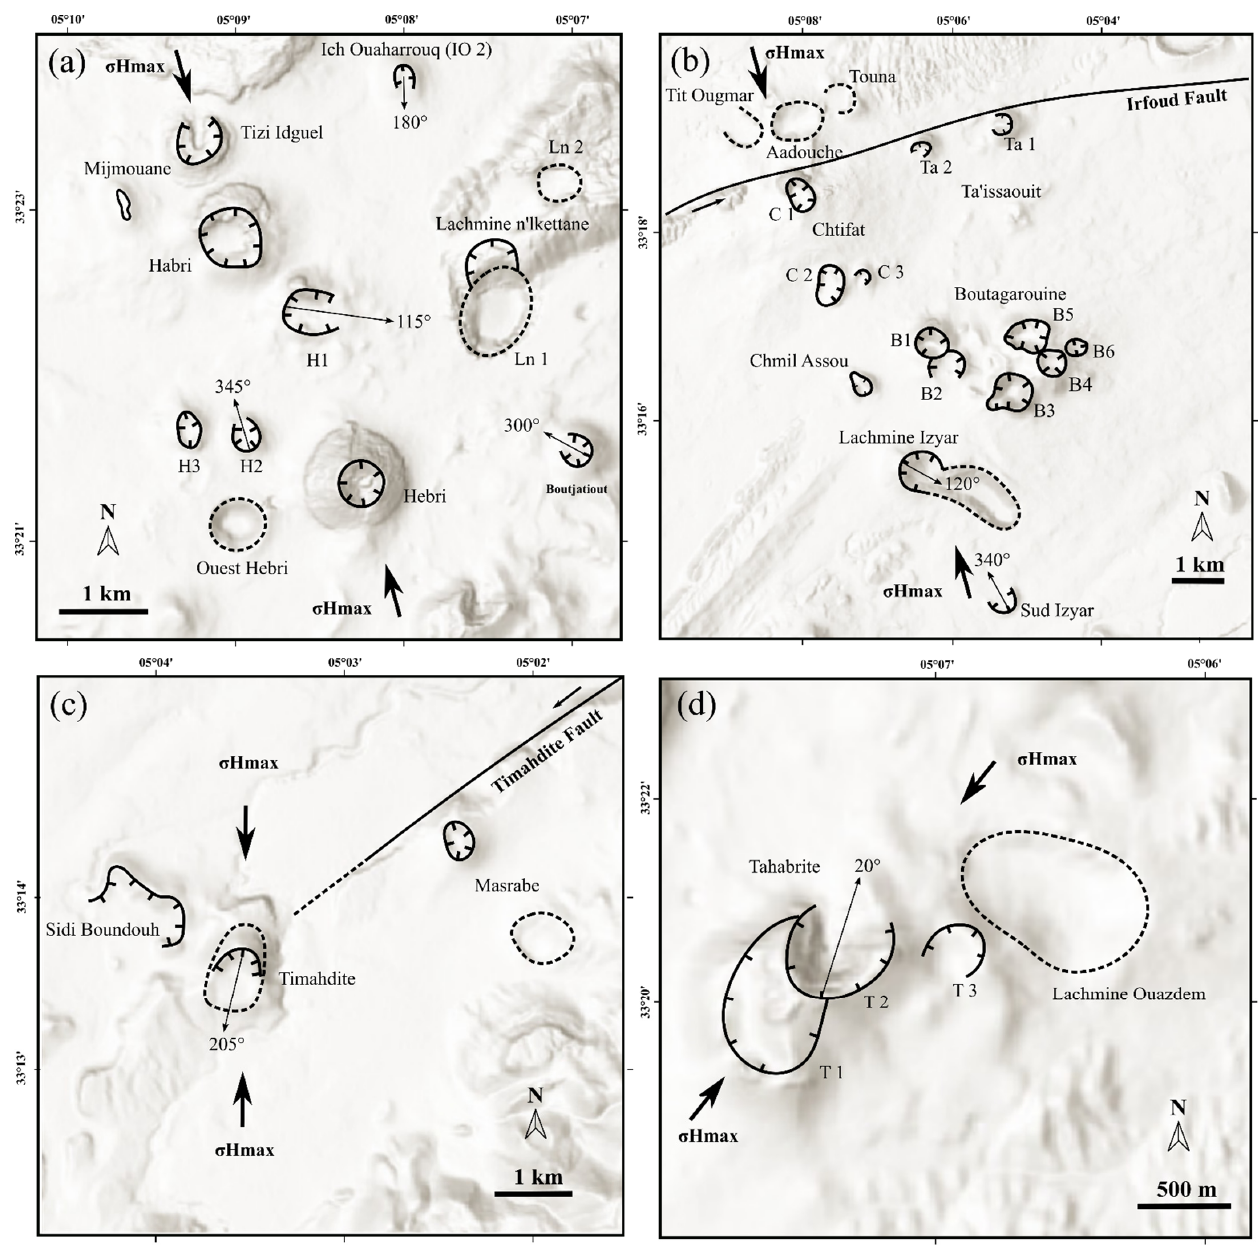
Figure 14. The distribution and alignment of volcanoes with the orientation of maximum horizontal stress ( σ Hmax), the pointed circles correspond to maars, the circles correspond to scoria cones: ( a ) Hebri volcanic field; ( b ) Chtifat and Boutagarouine volcanic com-plex; ( c ) Timahdite volcanic field; ( d ) Tahabrite volcanic complex.